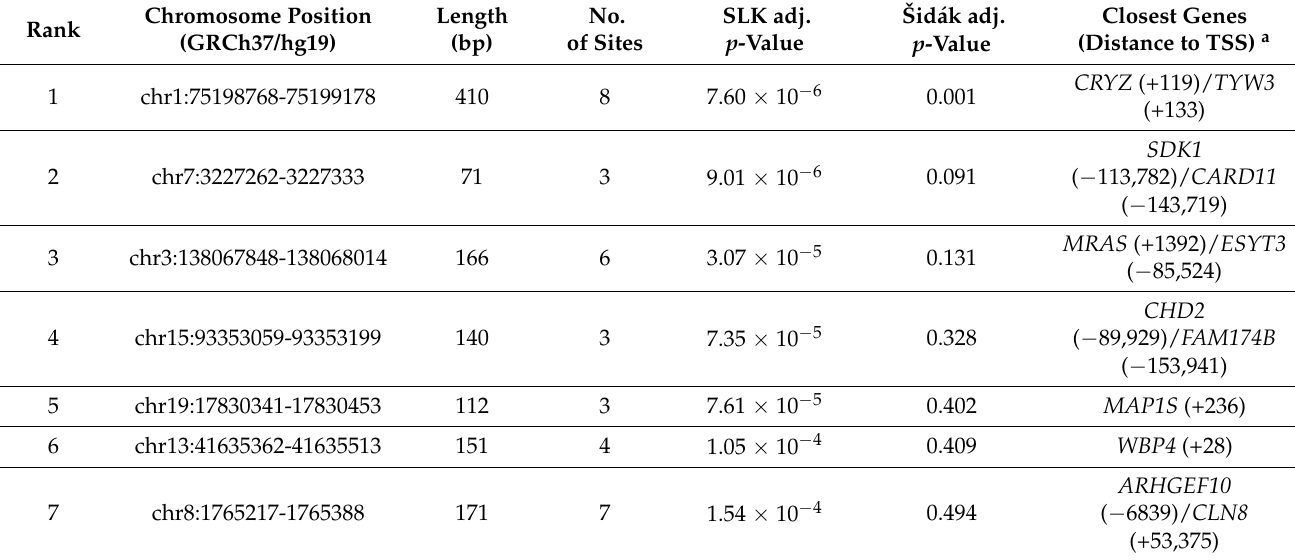
Table 3. Differentially methylated regions (DMRs) in TSD